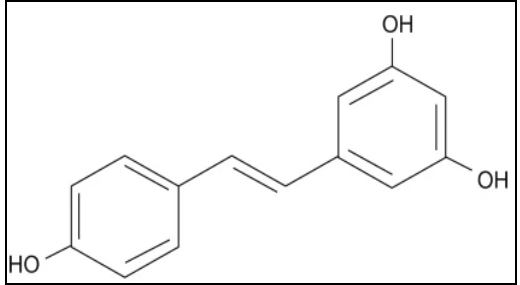
Figure 1. Chemical structure of resveratrol (48)